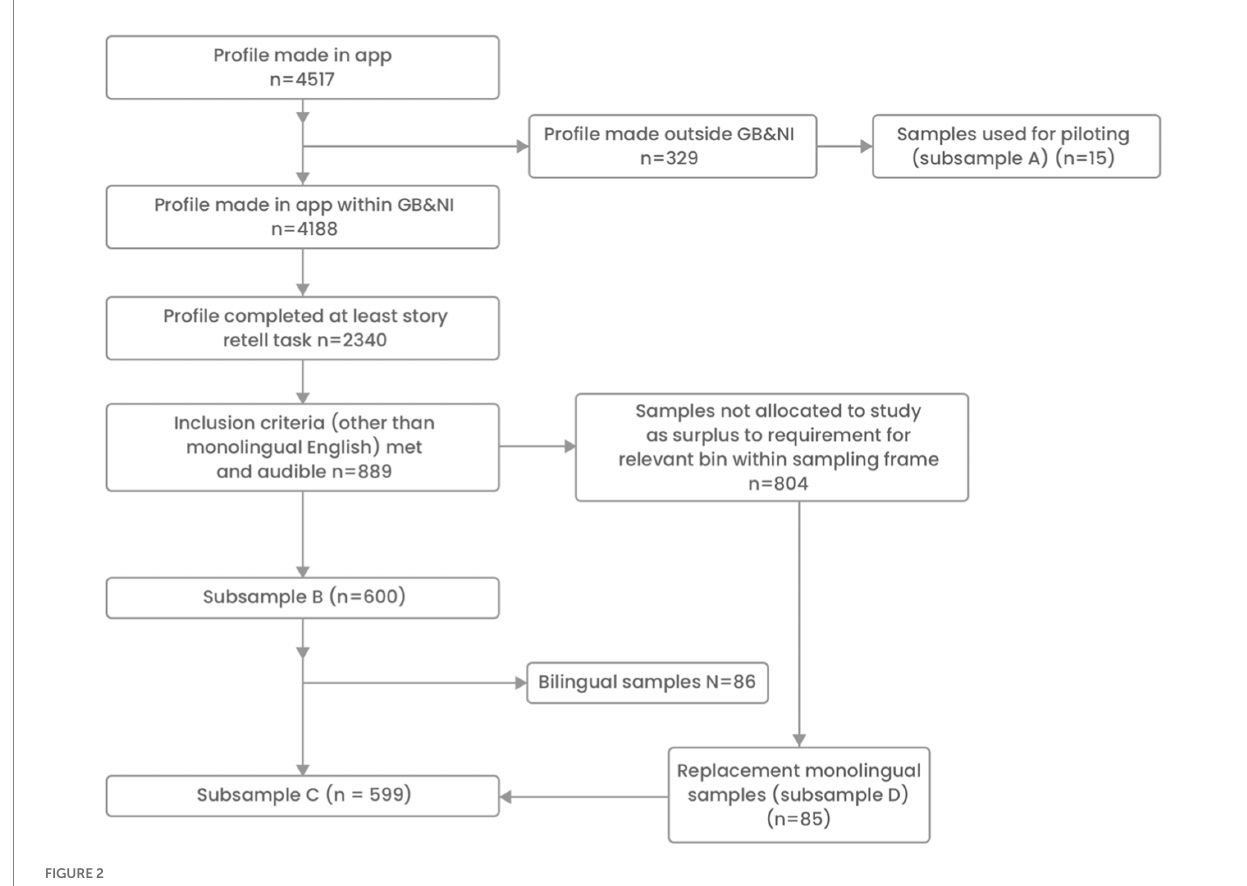
FIGURE 2 Participant flow